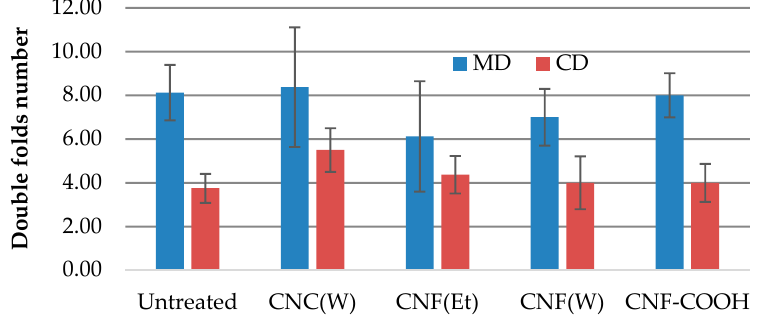
Figure 12. The strength properties of treated WBP are shown by double fold numbers.